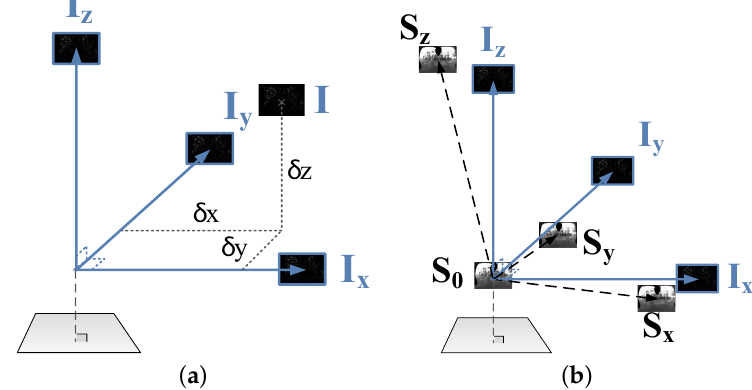
Figure 9. ( a ) Initialisation of the Image Coordinates Extrapolation (ICE) algorithm for visually-stablised hover. Once the desired hover position is defined by a reference snapshot S 0 , 3 snapshots ( S x , S y , S z ) are taken along the exploratory steps (dashed lines) to compute the difference images ( D x , D y , D z ) = ( S x − S 0 , S y − S 0 , S z − S 0 ). From these difference images, an orthonormal set of difference images is built to form the reference frame ( I x , I y , I z ) (shown in blue); ( b ) Coordinates ( δ x , δ y , δ z ) of the location of the current difference image are obtained by computing its inner products with the difference images forming the reference frame. Reproduced with permission from [92].